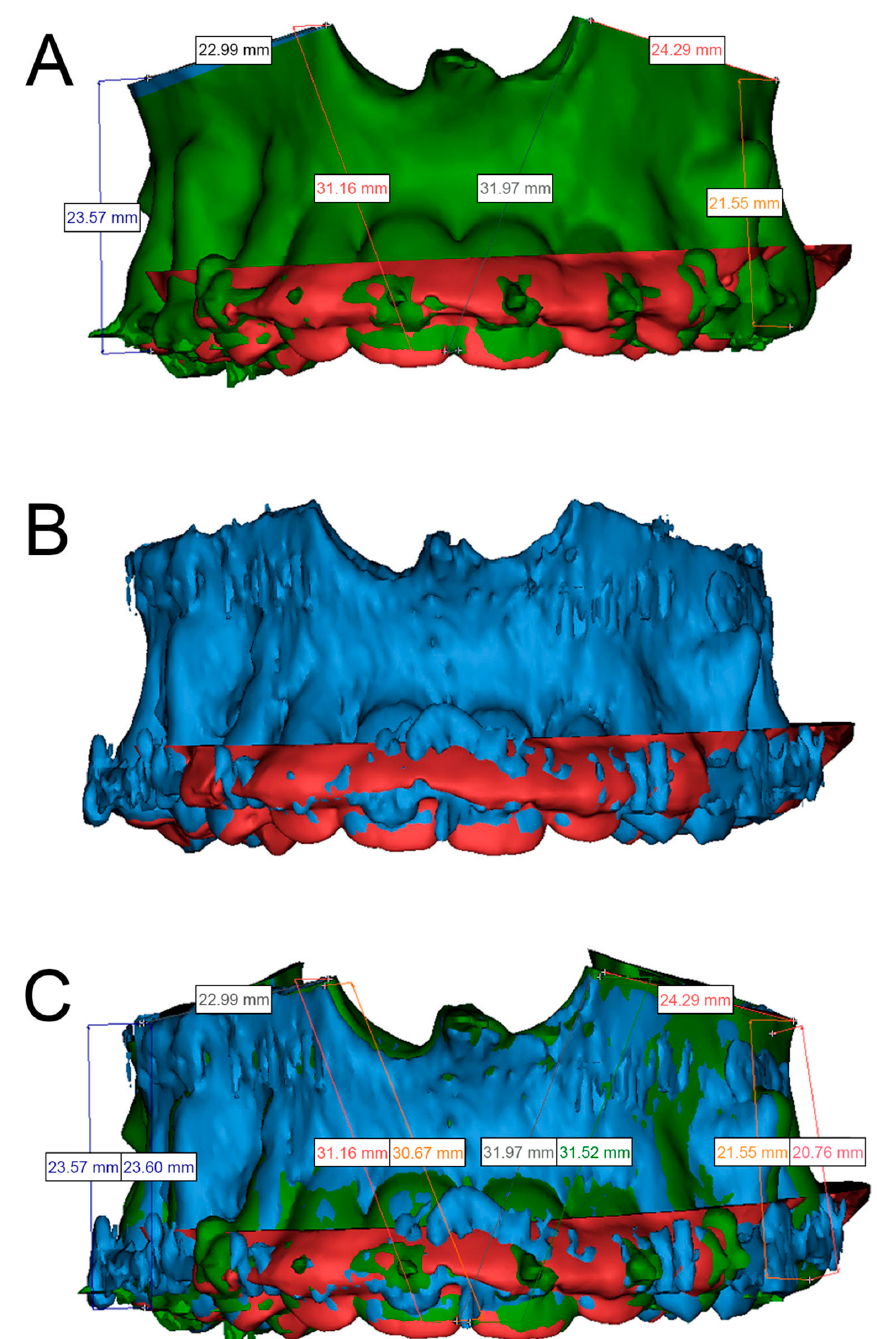
Figure 6. Superimposed preoperative (green) and postoperative (blue) segmented maxillae based on the intraoral dental surface scan (red). ( A ): Preoperative maxilla with an intraoperatively adjusted osteotomy line that was imported into Mimics. The intraoperatively adjusted osteotomy line on the right side of the maxilla is shown in blue, and the aligned dental surface scan is shown in red. The measured distances from the mesiobuccal cusps of the left and right upper molars to the lateral osteotomy line and from both incisors to the medial osteotomy line are shown. ( B ): Postoperative maxilla segmented in Mimics aligned with the dental surface scan shown in red. ( C ): Superimposition of the two maxillae based on the aligned dental surface scan. The measurements for each landmark are presented in pairs, with those on the left and right representing the planned and performed osteotomies, respectively. The difference was 0.03 mm from the mesiobuccal cusp of tooth 16 to the right lateral osteotomy line, 0.51 mm from the mesial surface of tooth 11 to the right medial osteotomy line, 0.45 mm from the mesial surface of tooth 21 to the left medial osteotomy line, and 0.79 mm from the mesiobuccal cusp of tooth 26 to the left lateral osteotomy